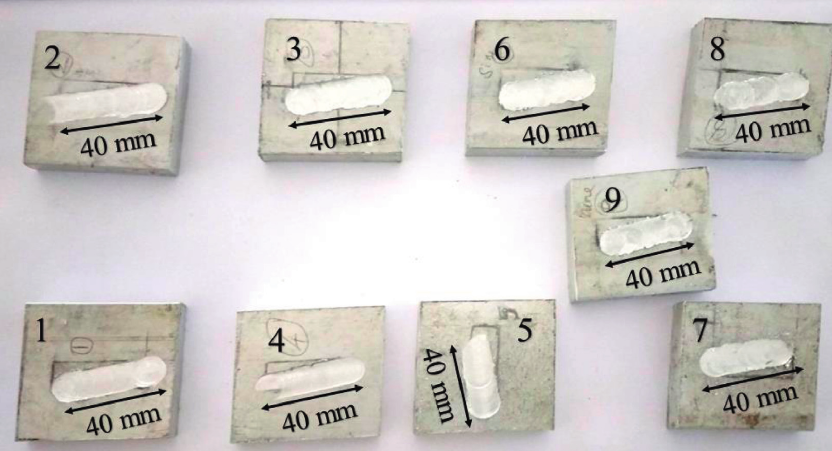
Figure 3: Machined work pieces of AA 2014 material. Table 6: Measured response for the corresponding input process parameter set. Exp.